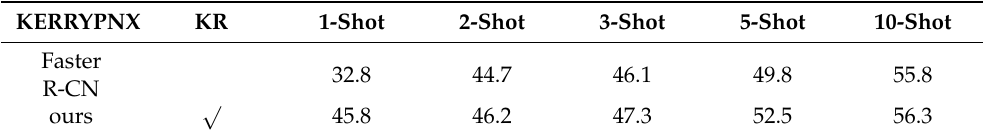
Table 6. Ablative performance (mAP50) on the